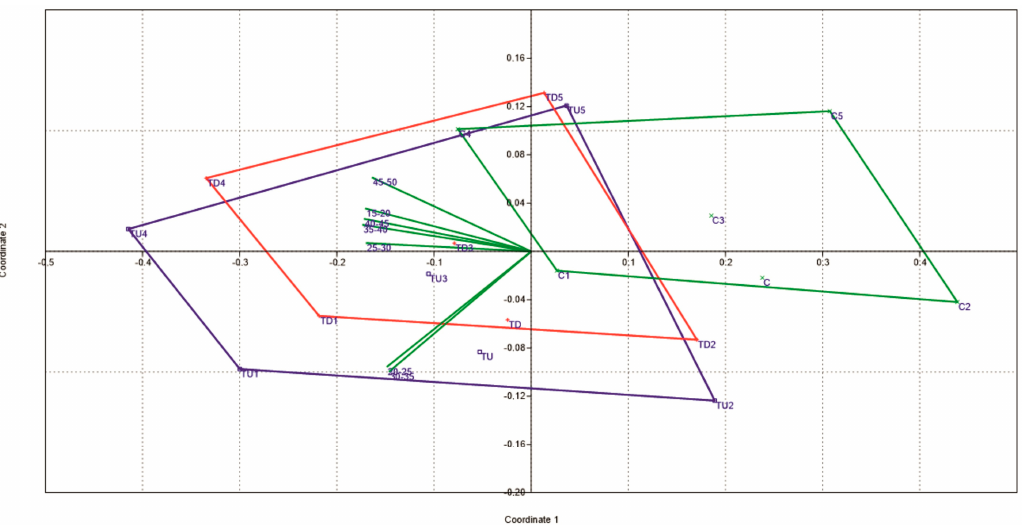
Figure 4. Non-metric multidimensional scaling (NMDS) of the average ring width per diameter class for the trees in the control area C (green polygon, N. = 5 plots, 7 diameter classes, 2 stem core samples = 70), for damaged trees TD (violet polygon, N. = 25 plots, 7 diameter classes, 1 stem core samples = 175), and for undamaged trees TU (red polygon, N. = 25 plots, 7 diameter classes, 1 stem core samples = 175) in the thinned area. The analysis is focused on a specific time period post thinning, from 1998 to 2017 (twenty rings—TPT2).